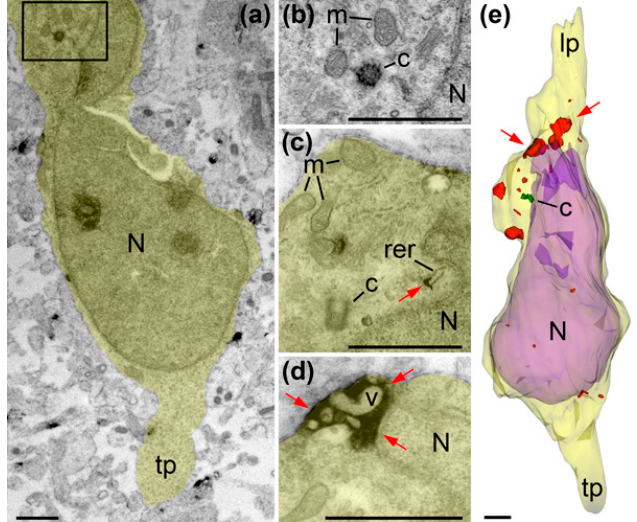
Figure 9. Electron micrographs ( a – d ) and 3D reconstruction ( e ) of a vertical bipolar cell in IZ of E45 rhesus macaque (also shown in Figure 10 as cell R23). The images are placed with a pia-directed segment up and the segment facing ventricular surface down. Cell body and proximal segments of truncated leading (lp) and trailing processes (tp) are shown semitransparent yellow, and nucleus (N) is semitransparent violet. Framed area in ( a ) is enlarged in ( b ). Serial not adjacent images ( b , c ) show both centrioles (c; depicted green in ( e )). Small anti-CB 1 R-L31 immunoreaction deposition (red arrow in c ) on the surface of cisternae of rough endoplasmic reticulum (rer) likely identifies a site of CB 1 R biosynthesis. Numerous intracellular vesicles (v) are surrounded by abundant anti-CB 1 R depositions (red arrows in ( d )) forming big CB 1 R-positive globules such as shown in red in ( e ). Abbreviation: m, mitochondria. Scale bars: 1 μ m.